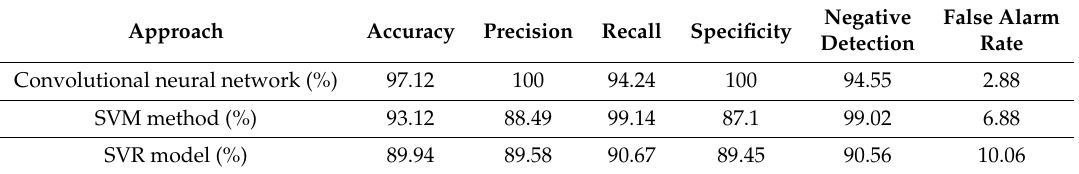
Table 30. Comparison of detection evaluation indices among the three methods for generator